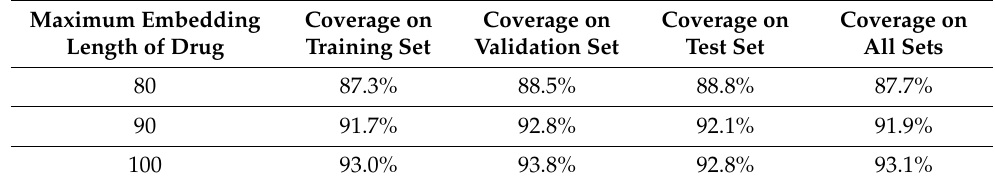
Table A2. Drug maximum length coverage.